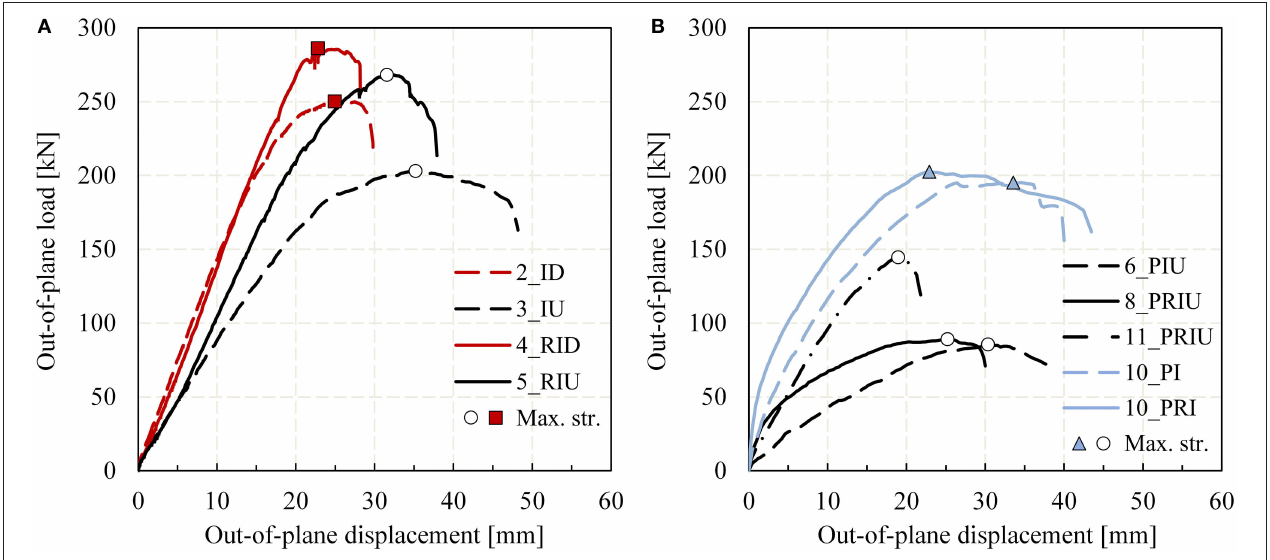
FIGURE 13 | Out-of-plane force–displacement curves for fully filled specimens (A) and for partial infill walls (B) .